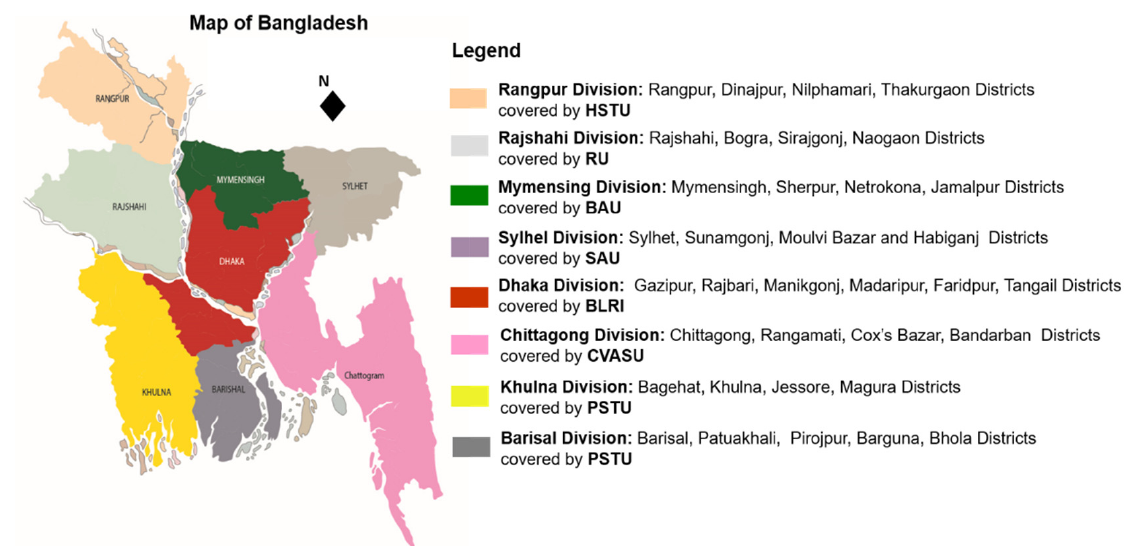
Figure 4. AMR surveillance study areas covered by seven components (educational institutes).